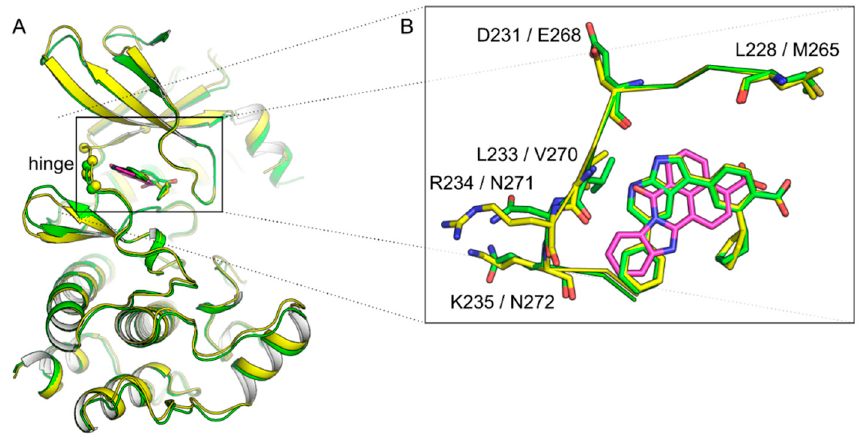
Figure 2. ( A ) Superimposed structures of CAMKK1 (yellow, PDB 6CD6) and CAMKK2 (green, PDB 6BKU) bound to GSK650394. STO-609 (as bound to CAMKK2, PDB 2ZV2) is also shown in magenta. Spheres show positions where residues di ff er within the ATP-binding site of the two CAMKKs. ( B ) Inset shows a top view of the ATP-binding sites of both CAMKKs.